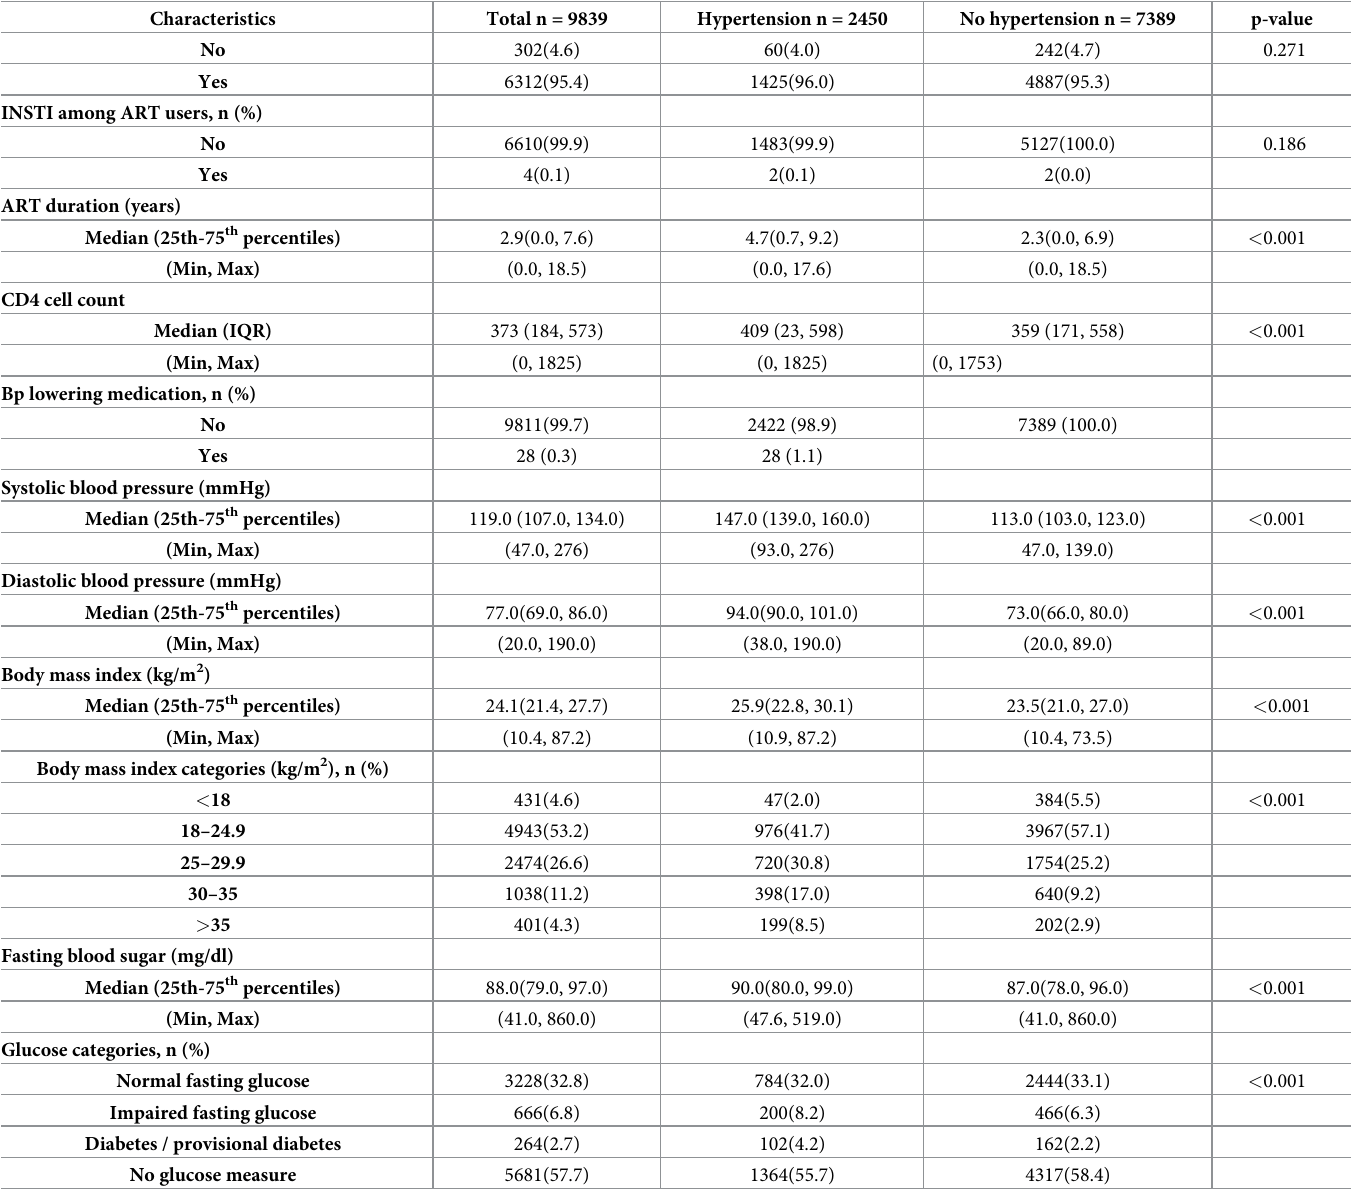
HTN prevalence after 2 years (Fig 3). Treatment and control of HTN Among participants with HTN, 2422(98.9%) were not receiving any antihypertensive medica- tion; and of the 28 (1.1%) receiving treatment, 6 (21.4%) had a controlled BP (Fig